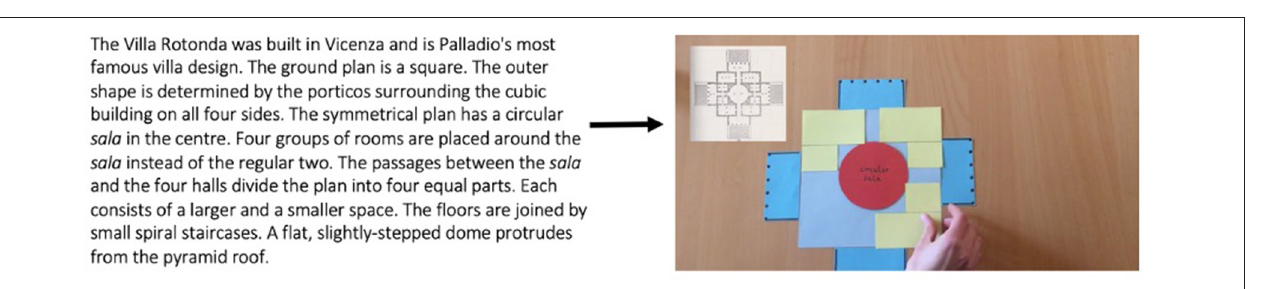
material and its properties are entirely absent from the model, represented instead by dramatically simplified paper